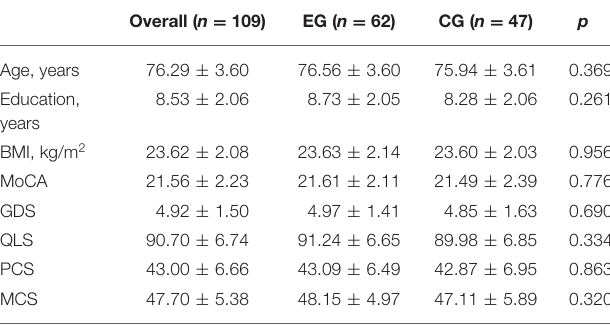
TABLE 1 | Baseline characteristics of